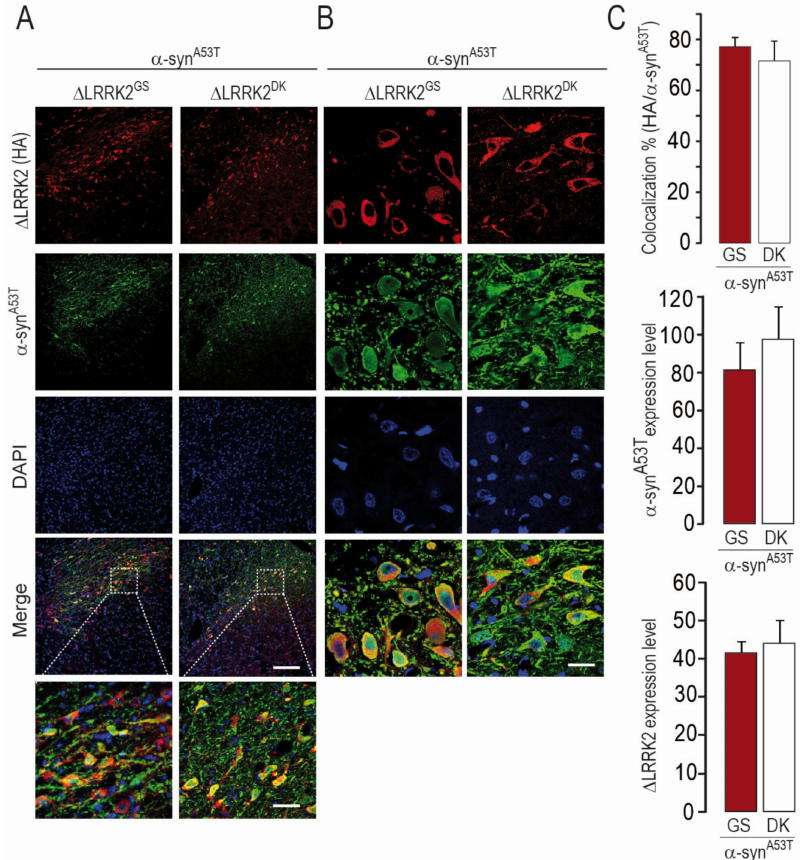
Figure 8. Co-localization and expression of ∆ LRRK2 and α -syn A53T 6 weeks after the co-injection of AAV- α -syn A53T with either AAV- ∆ LRRK2 G2019S or AAV- ∆ LRRK2 G2019S/D1994A . ( A , B ) Photomi- crographs showing the results of immuno-fluorescence detection of ∆ LRRK2 G2019S ( ∆ LRRK2 GS ) or ∆ LRRK2 G2019S/D1994A ( ∆ LRRK2 DK –red channel) and α -syn (green channel). Left and right images were obtained at low ( A ) and high ( B ) magnification, respectively. Note that most neurons express both transgenes. Scale bars: 200 µ m for the top images, 50 µ m for the bottom images in ( A ), and 10 µ m for the bottom images in ( B ). ( C ) Quantification of the percentage of co-localization (upper histogram), α -syn fluorescence (middle histogram), and ∆ LRRK2 fluorescence (bottom histogram) based on the analysis of 20 cells per animal, 180 cells in total. Results are expressed as the means ± SEM. N = 4–5 animals/group. No statistical difference between groups, Student’s t